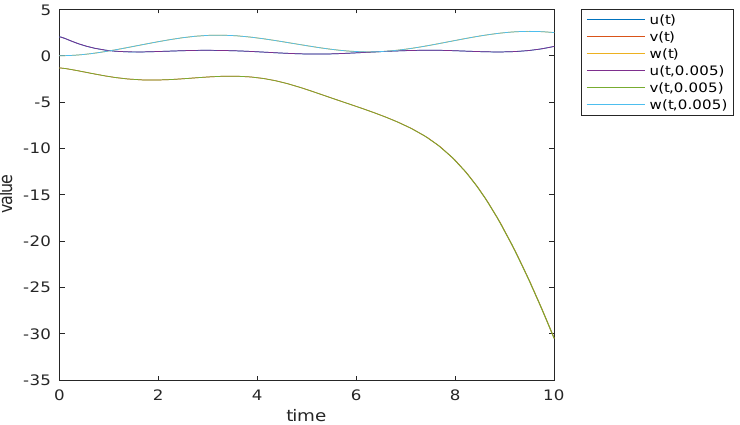
Figure 6. Simulation of solutions of the integer-order equation corresponding to Example 3.